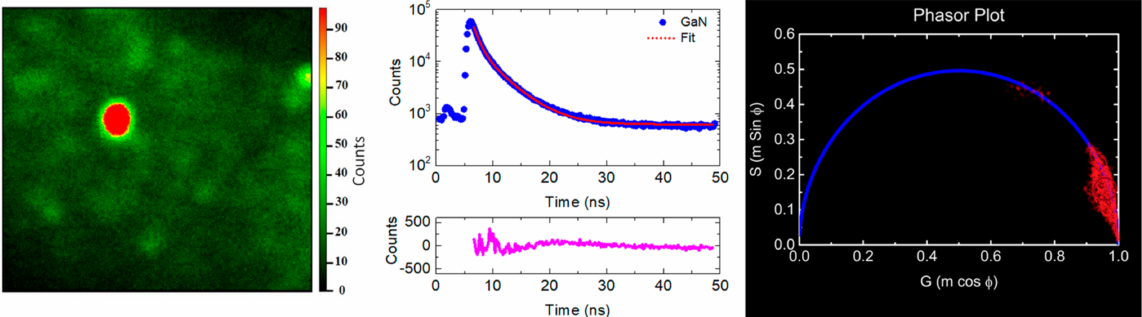
Figure 6. The raw FLIM data for GaN. The middle panel shows the photoluminescence intensity decay with the fitting curve. The curve at the bottom panels is the fitting residual. The left panel in is the phasor plot representations from fluorescence FLIM